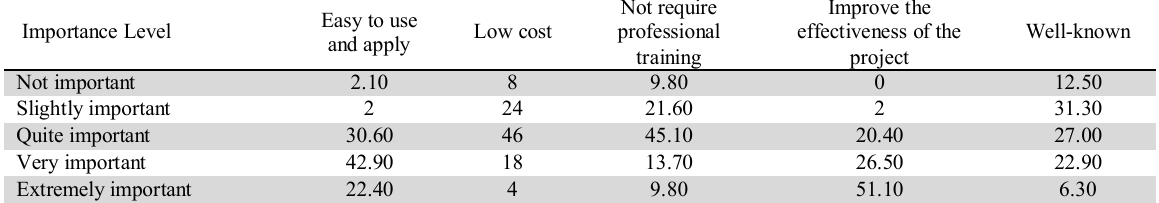
Improve the effectiveness of the